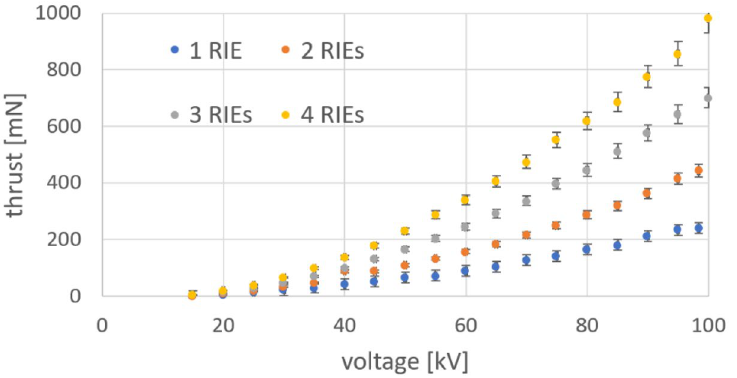
Figure 9. The toroidal axial thrust dependence on the voltage and the number of parallel-connected units/ toroidal RIEs used. The error bars represent potential measurement errors related to setting the voltage (up to 0.2 kV) and 5% thrust errors (due to the mounting of the RIE on the measuring device and electronic scale readings.